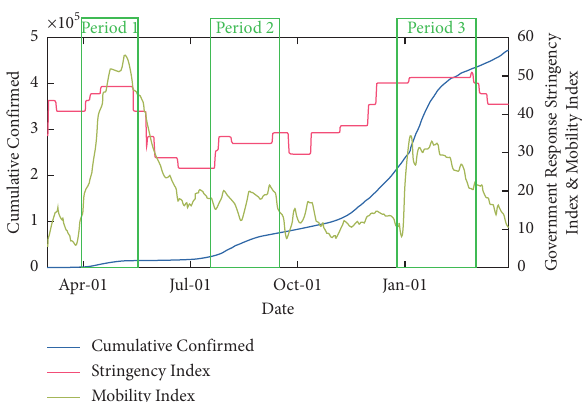
Figure 5: Japan cumulative confirmed cases, stringency index, and mobility index (March 1, 2020–March 31, 2020).